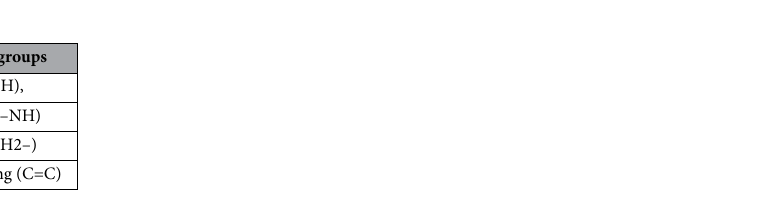
Table 1. Fourier transforms infrared spectroscopy